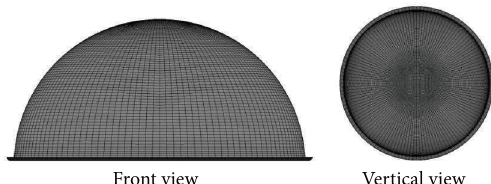
Figure 6: Preliminary FE mesh of the reversal